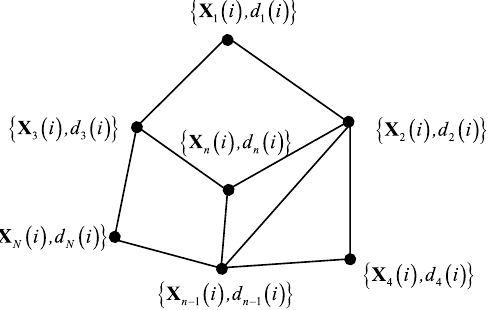
Figure 1. A network consisting of N agents 18,28,41